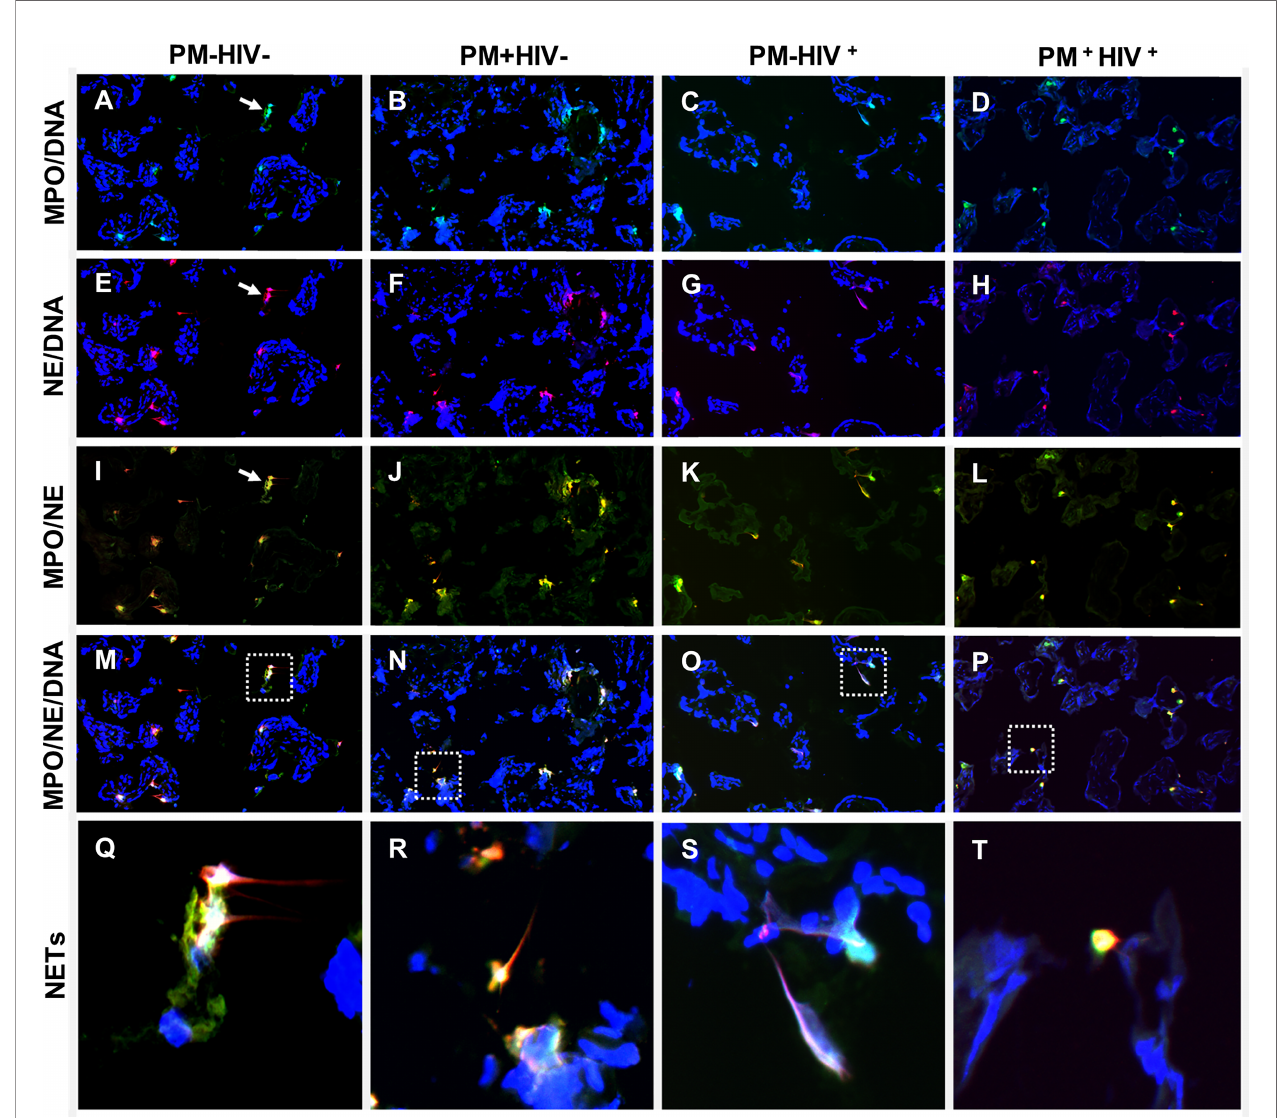
FIGURE 9 | Detection of NETs by immun fl uorescence in placental tissue. Immunolocalization of MPO (green), NE (red) in term placenta. The DNA was labeled with Hoescht 33342 (blue). (A, E, I, M, Q) uninfected placenta; (B, F, J, N, R) PM+HIV- placenta; (C, G, K, O, S) PM-HIV+ placenta; and (D, H, L, P, T) PM+HIV+ placenta. The fi rst row (A – D) shows the colocalization of MPO with DNA, the second row (E – H) , colocalization of NE and DNA, the third row (I – L) , colocalization of MPO and NE and the fourth row (M – P) , colocalization of MPO, NE and DNA. The last row shows in higher magni fi cation the dotted areas in panels (M – P) that contain putative NET-like structures (Q – T) . Arrows in panels (A, E, I) indicate NET-like structures. Groups are as de fi ned in Figure 2